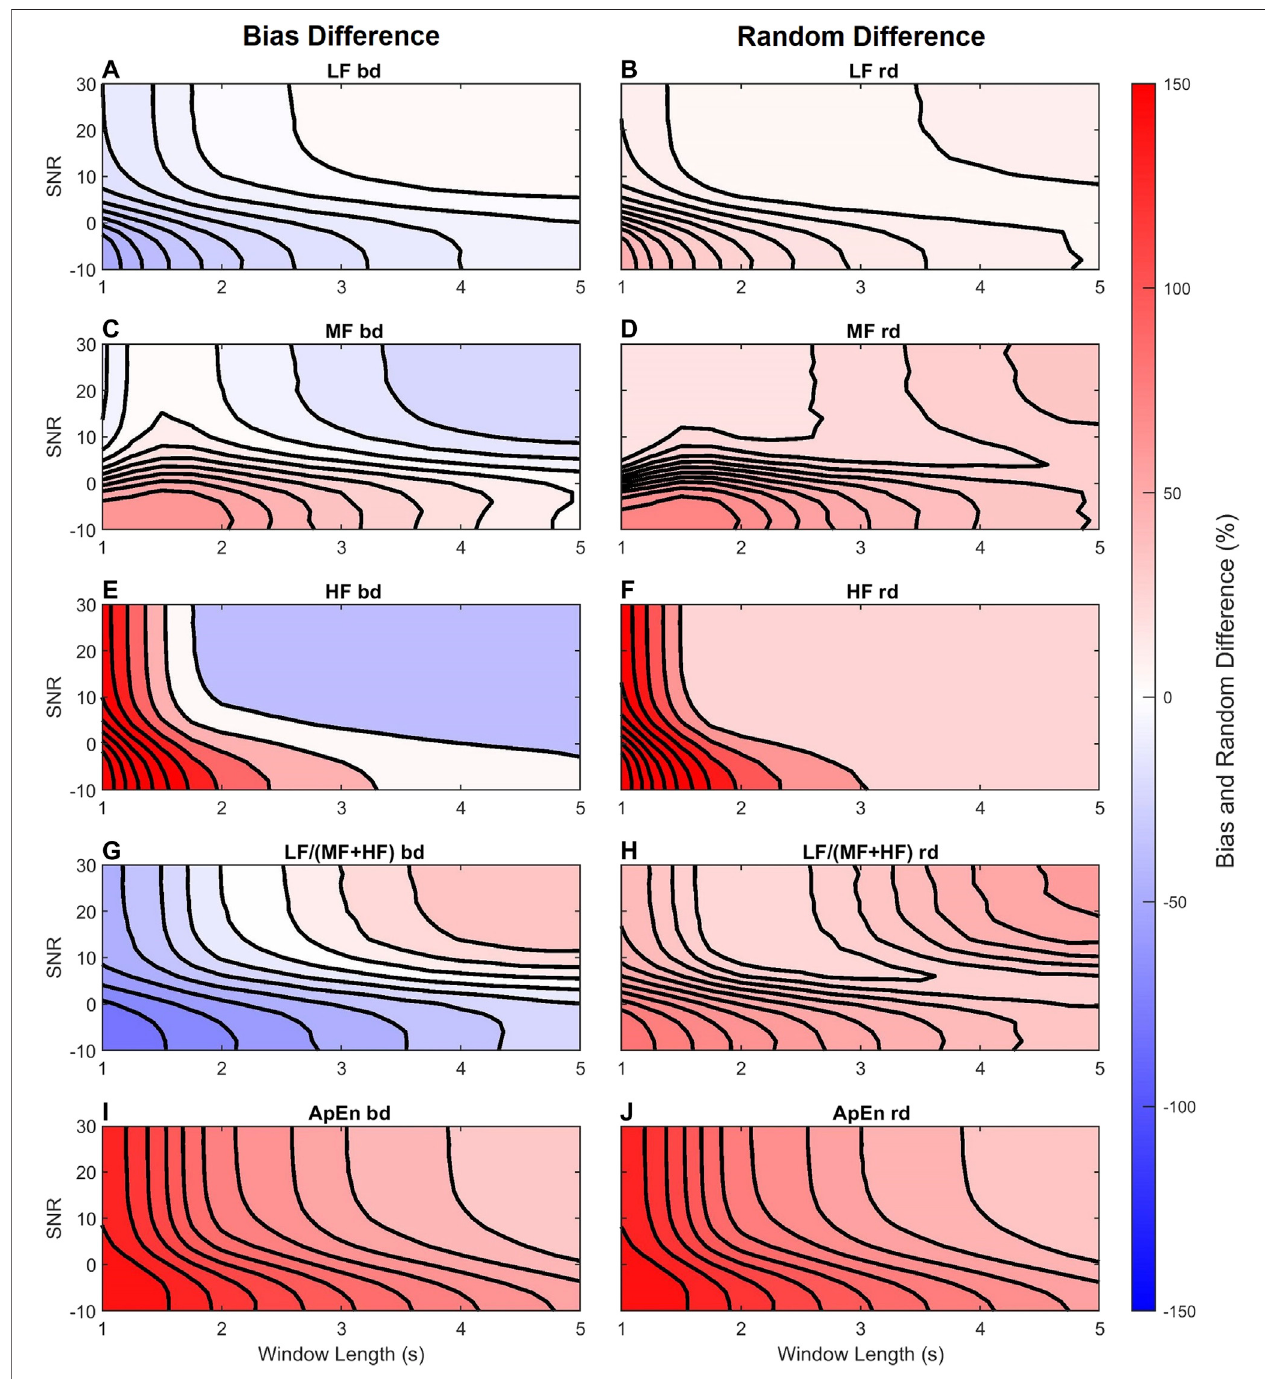
FIGURE 6 | Contour plots of the bias difference, bd , and random difference, rd , of the LF (A,B) , MF (C,D) , HF (E,F) , LF/(MF + HF) (G,H) , and ApEn (I,J) features from FHR DUS for the acidosis distributions and varying AC window length (horizontal axis) and SNR (vertical axis). The differences are coded in colors blue (negative), white (zero), and red (positive) according to their magnitude. For visualization, 10 isolines are used in each panel.